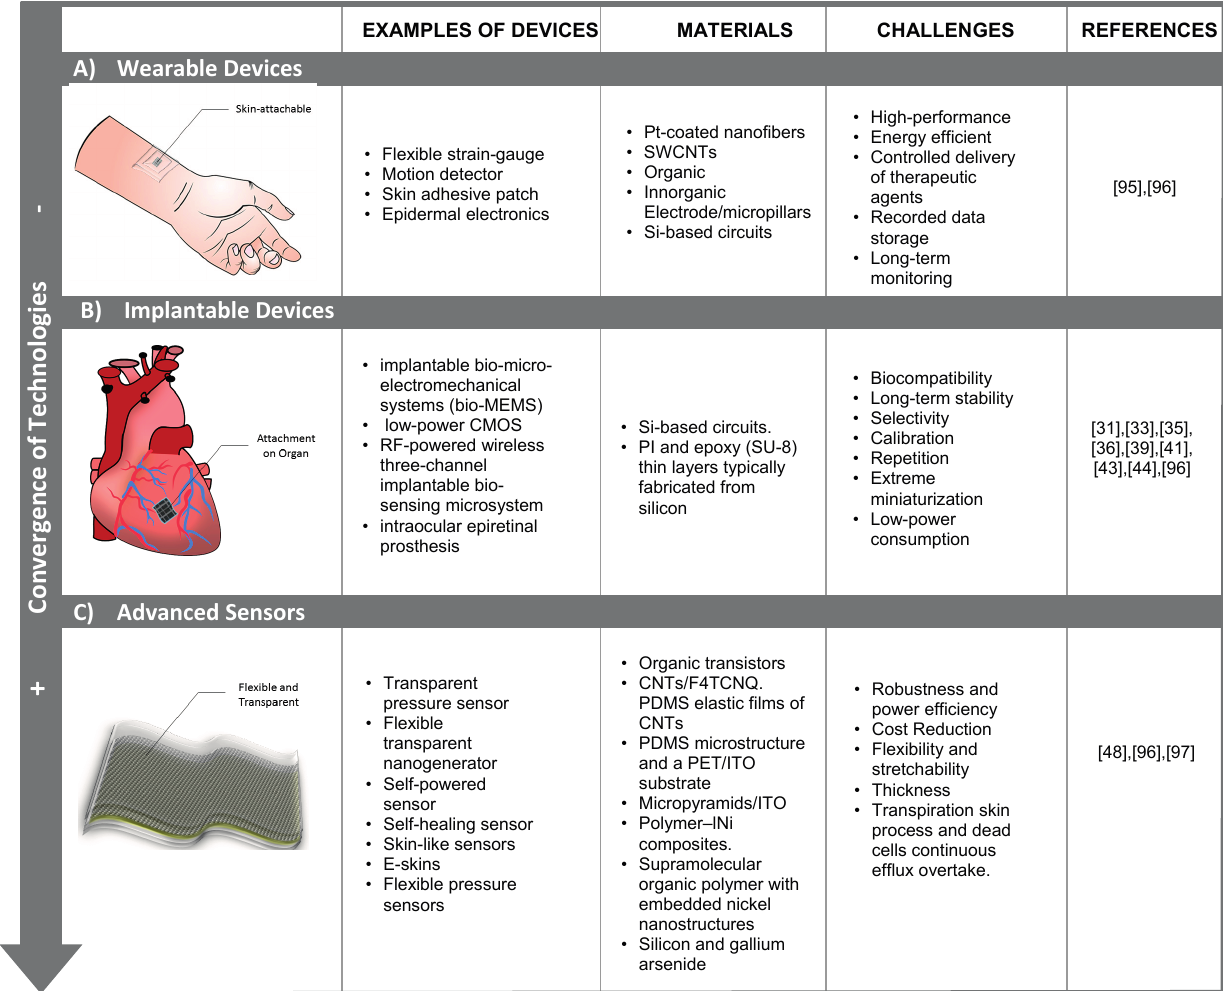
Figure 5. Summary of main devices for biomarkers